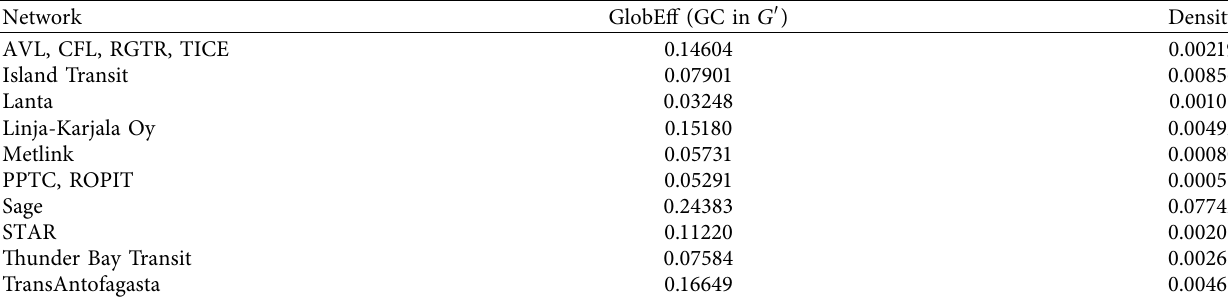
Table 10: GlobEff and density in GC in G ′ for all analyzed networks.